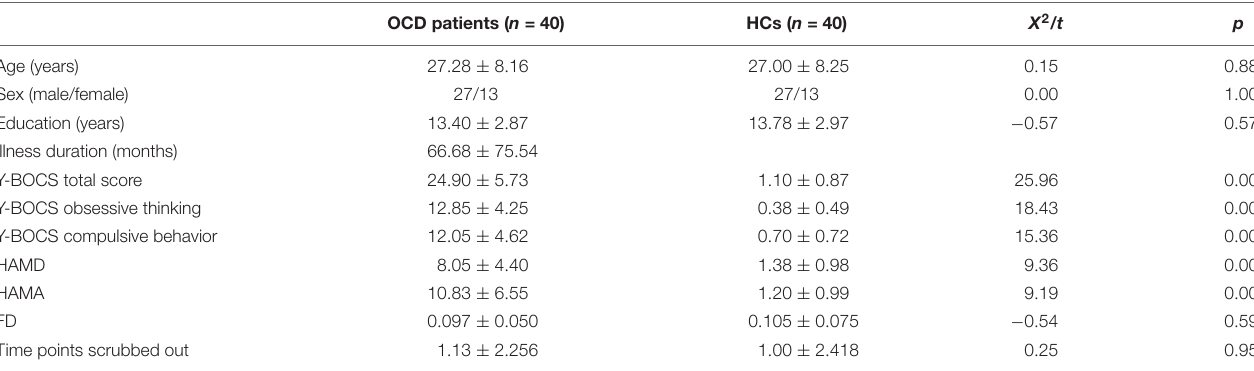
TABLE 1 | Demography and clinical characteristics in patients with OCD and